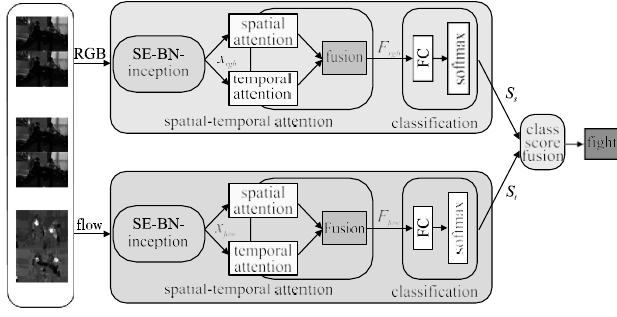
Figure 1. Structure of the proposed spatio-temporal